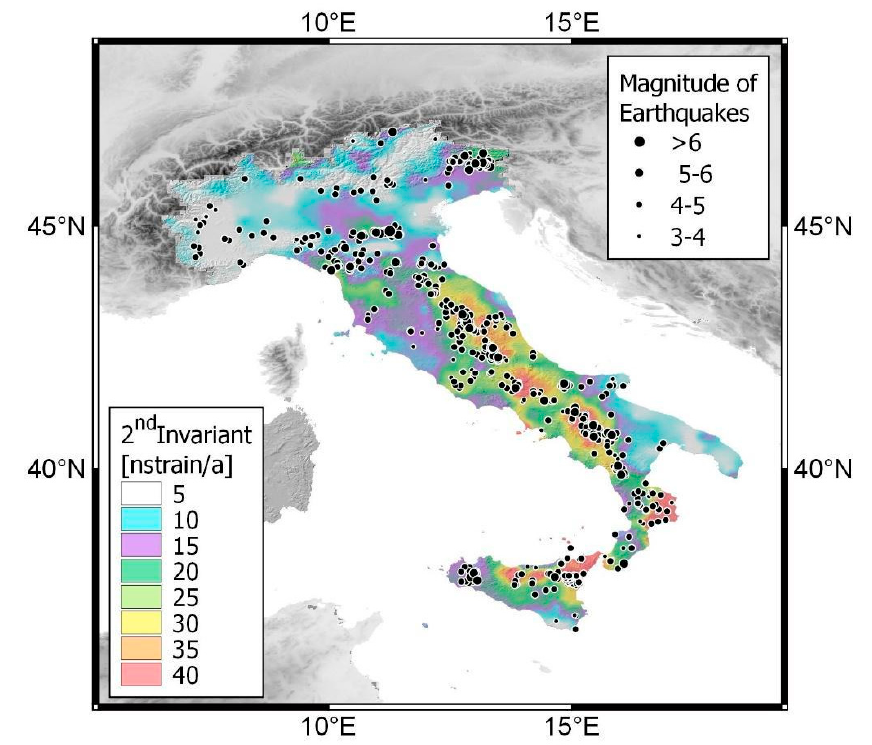
Figure 4. Map of the horizontal strain rate field of the Italian peninsula, determined by an infinitesimal approach from the horizontal velocity field derived from GNSS and InSAR during more than two decades of observation (1990–2017). Main earthquakes that occurred from 1990 to 2017 are represented on the map.